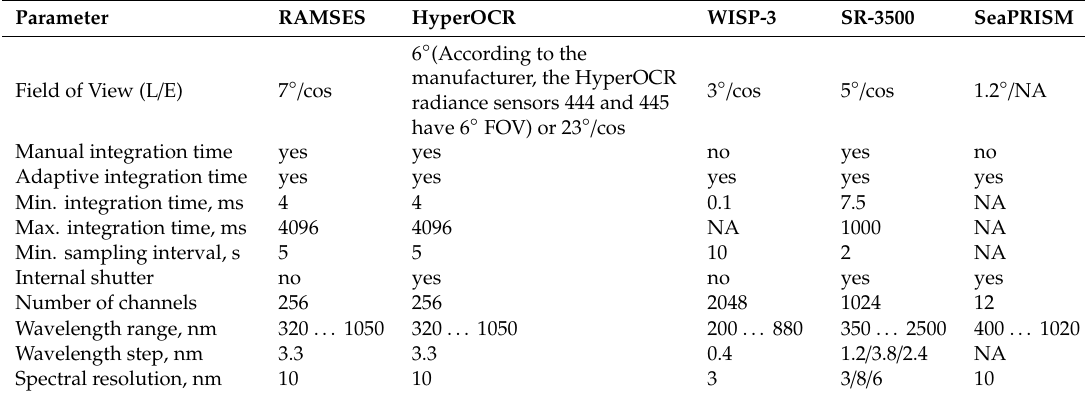
Table 2. Technical parameters of the participating radiometers.